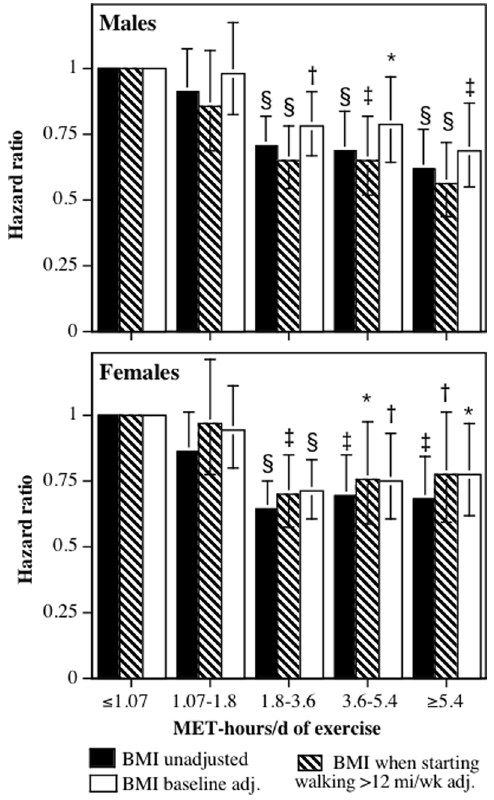
Figure 1. Relative risk (hazard ratio) for all-cause mortality vs. exercise energy expenditure adjusted for age (age plus age 2 ), race, education, smoking status (current and prior history), prior history of heart attack and cancer, daily intakes of alcohol, meat and fruit, aspirin use. Brackets designate 95% confidence intervals. Significance levels for the risk reduction relative not achieving the minimum recommended exercise level (i.e., , 1.07 MET-hours/d) are coded: * P , 0.05, { P , 0.01, ` P , 0.001, and 1 P , 0.0001.